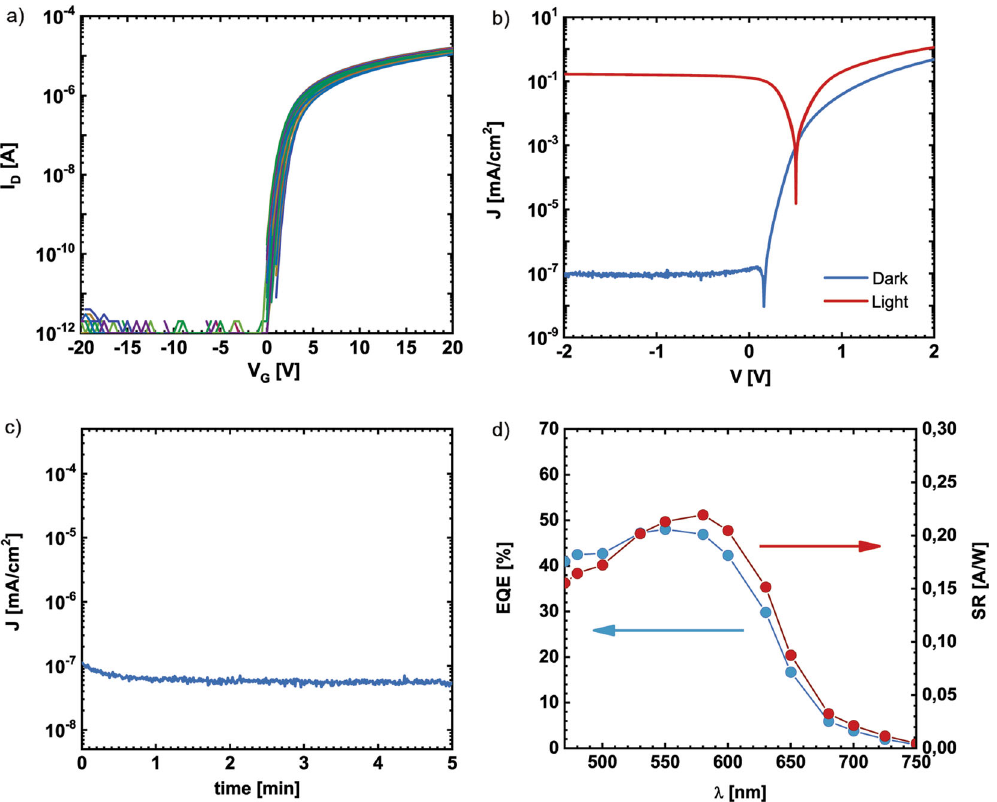
Fig. 3 Characteristics of discrete IGZO TFTs and OPDs. a Transfer characteristics of 25 IGZO TFTs (W/L 60/20 µm) distributed over a GEN1 substrate (320 × 352 mm), measured at a source – drain voltage of 1 V. b Current density of OPD as a function of voltage under dark (blue) and low light intensity (red) conditions (light intensity of ca. 0.1 mW/cm 2 ). c Current density of OPD as a function of time measured at − 2 V under dark conditions. d EQE (blue) and spectral response (red) of OPD as a function of